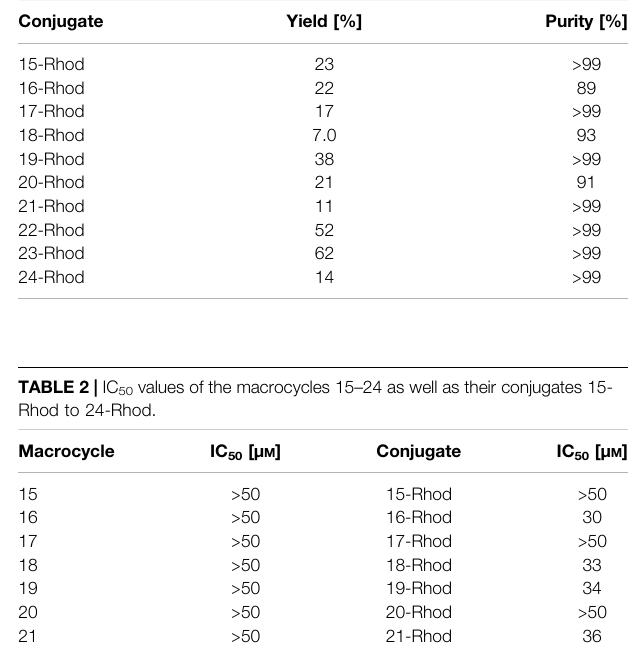
TABLE 1 | Isolated yields and purities of the luminescent conjugates 15-Rhod to 24-Rhod. Conjugate